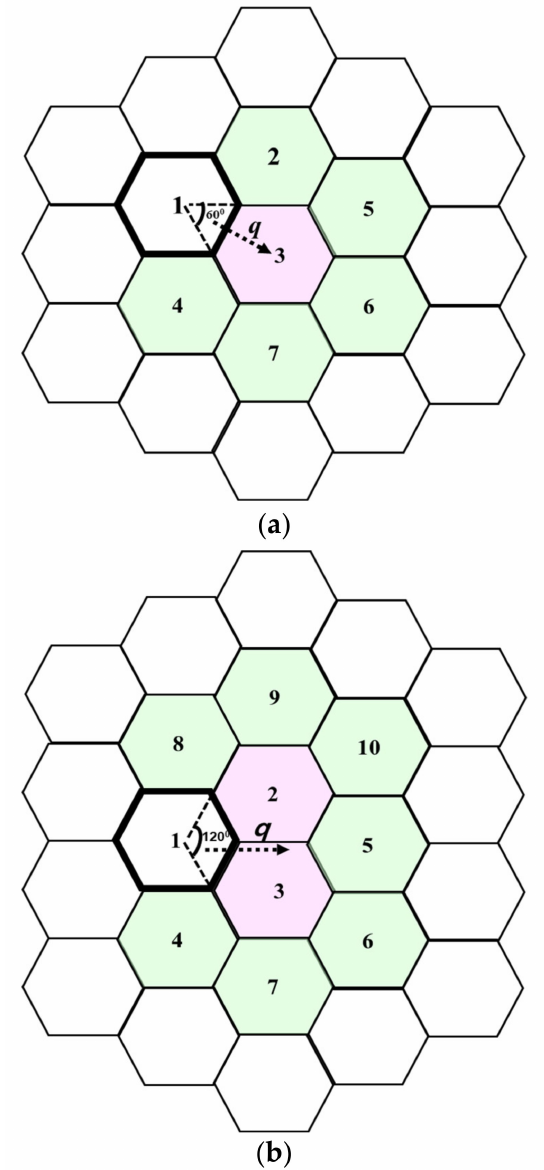
Figure 1. TAL forming scheme depending on UE’s moving direction prediction. ( a ) Urban area (small sector, 60 ◦ ); ( b ) Rural area (big sector, 120 ◦